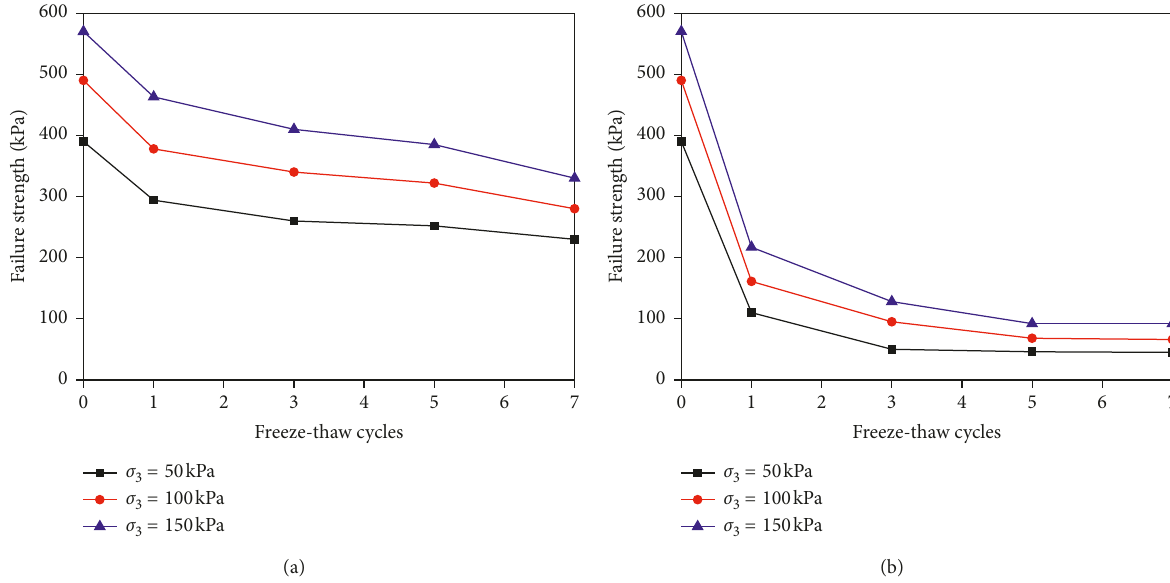
Figure 11: Variation of failure strength with the number of freeze-thaw cycles. (a) Closed system. (b) Open system.